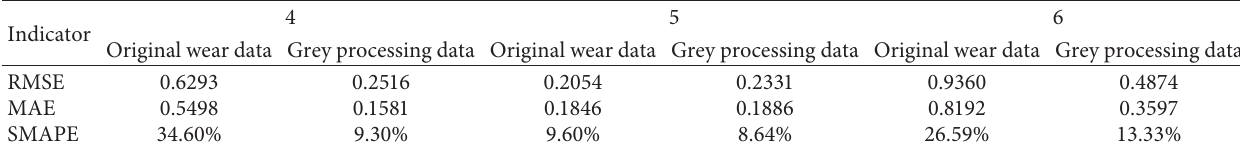
Table 1: The RMSE, MAE, and SMAPE of the predicted values.